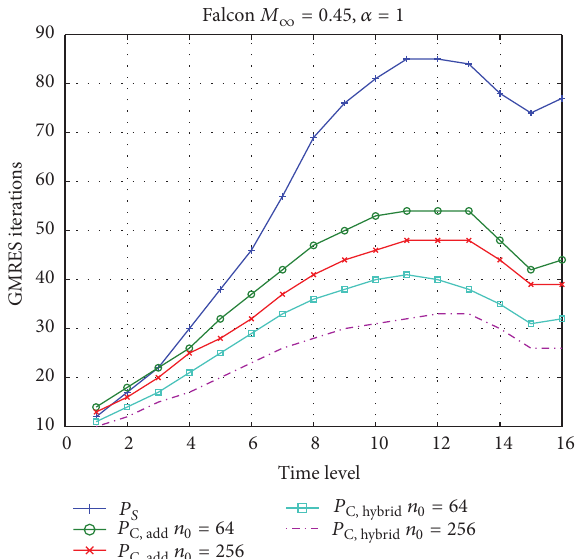
dimension of the coarse space for the